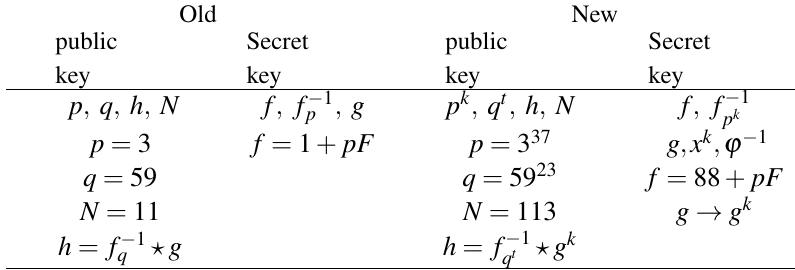
Table 1 The proposed NTRU